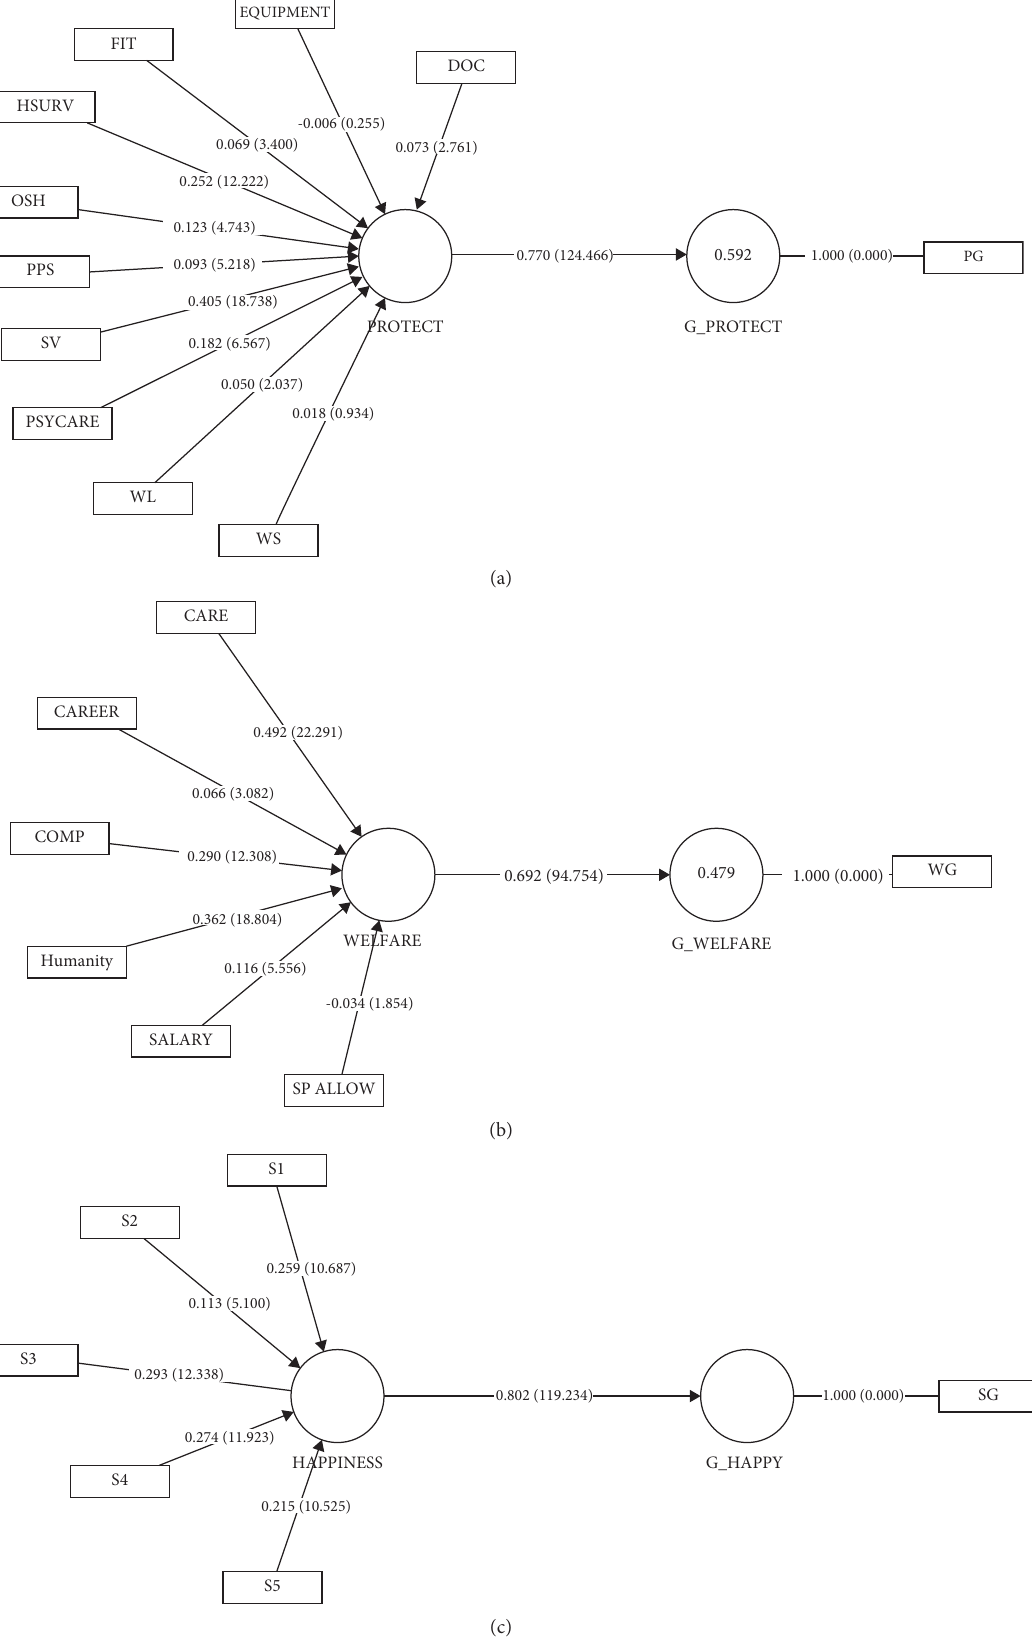
Figure 3: Convergent validity by redundancy